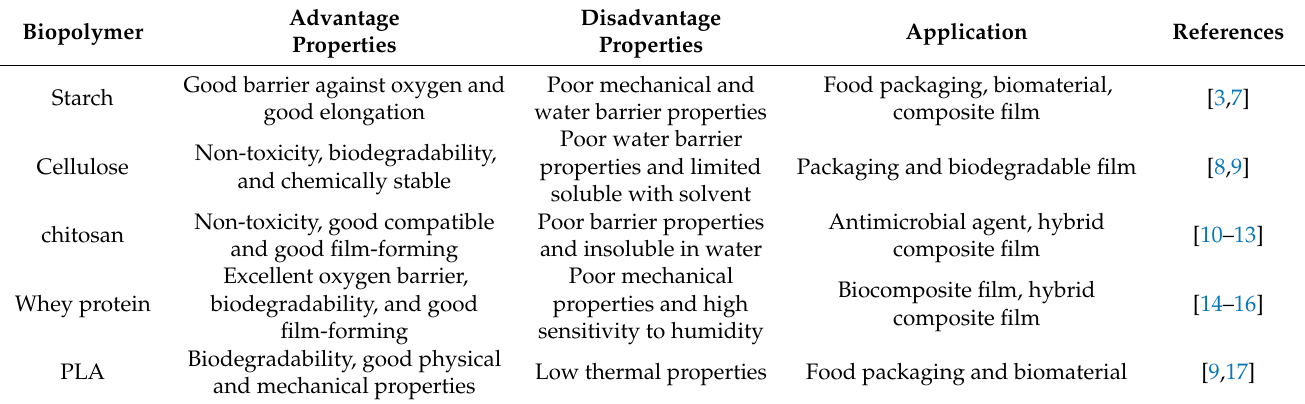
Table 1. The primary type of biopolymer in the development of packaging